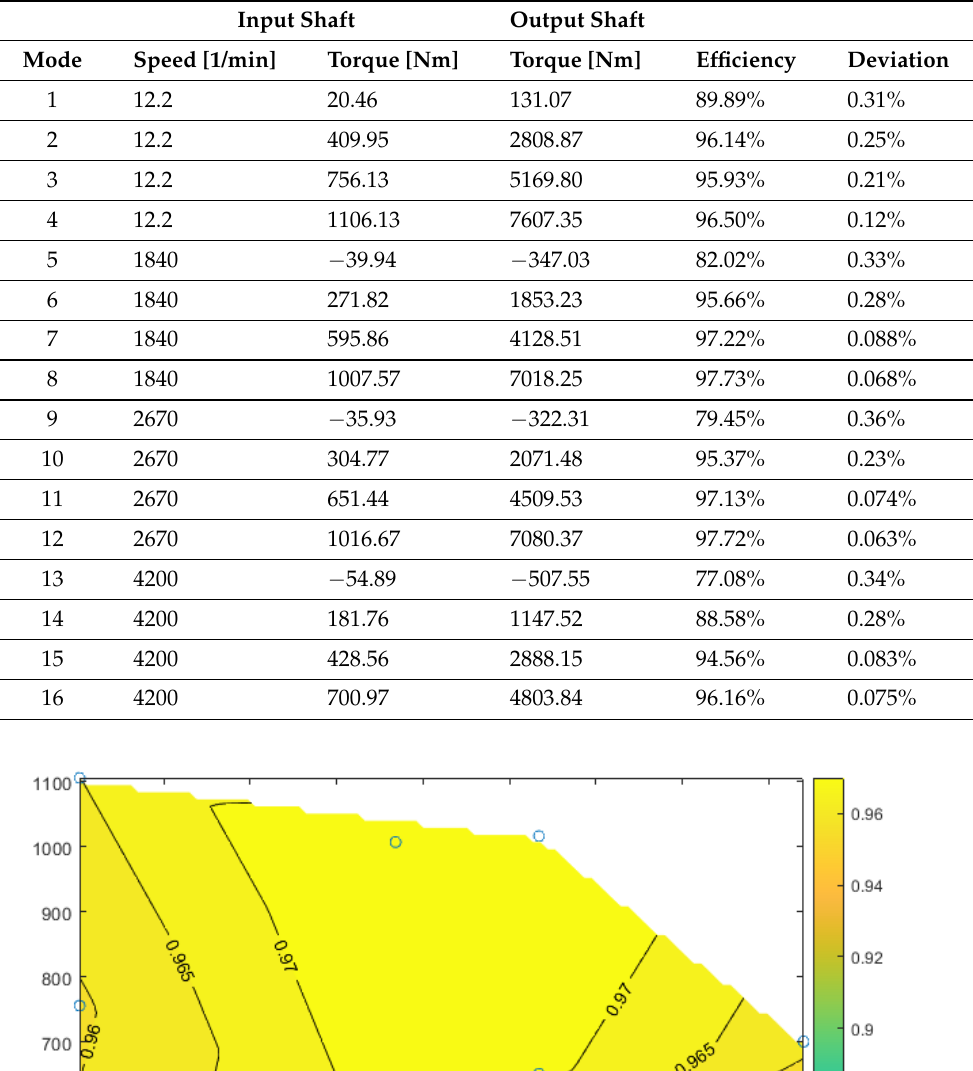
Table 1. The efficiency—measured data.